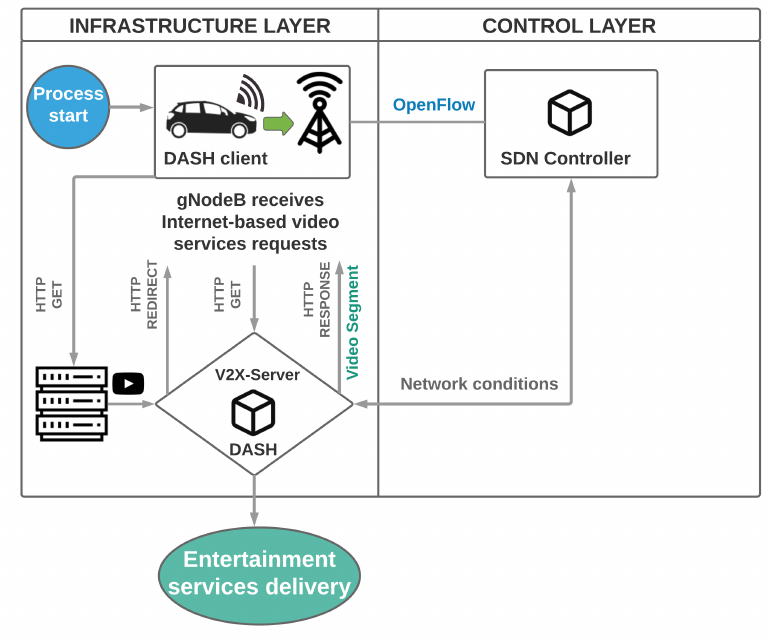
Figure 5. Operation of the proposed